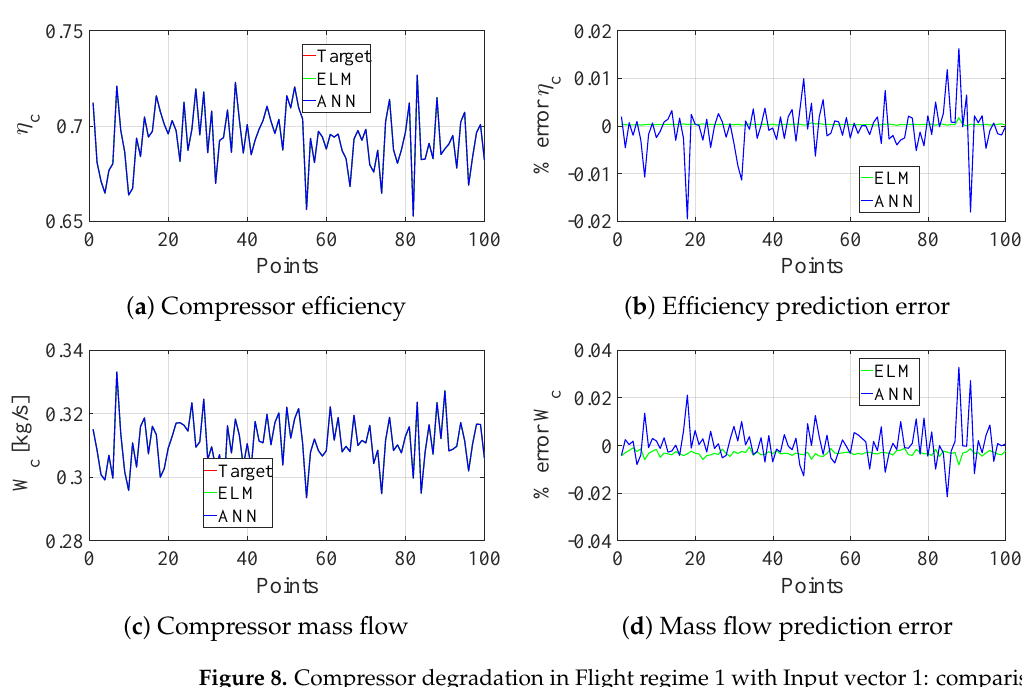
Figure 8. Compressor degradation in Flight regime 1 with Input vector 1: comparison between the target and prediction of the component performance parameters.